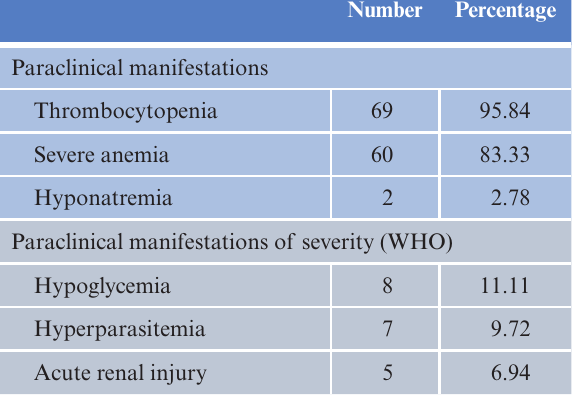
Table 4: Distribution of children with severe malaria and renal impairment according to paraclinical manifestations at Borgou DTH in 2021 (n = 72).